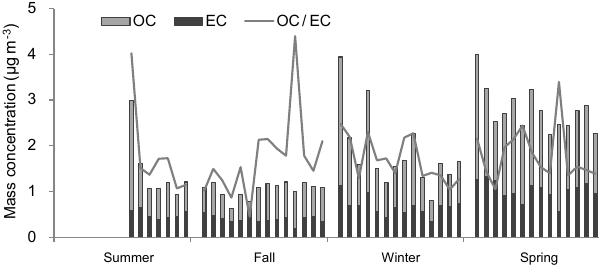
Figure 3. Daily and seasonal variation of observed PM 2 . 5 mass con- centration.